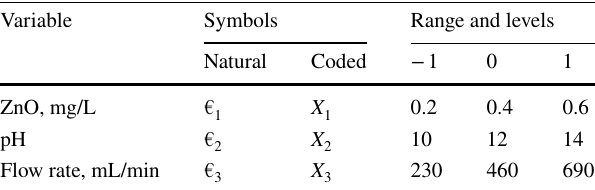
Fig. 2 Effect of UV illumination time on the dye photodegradation Table 1 Experimental range and levels of the independent